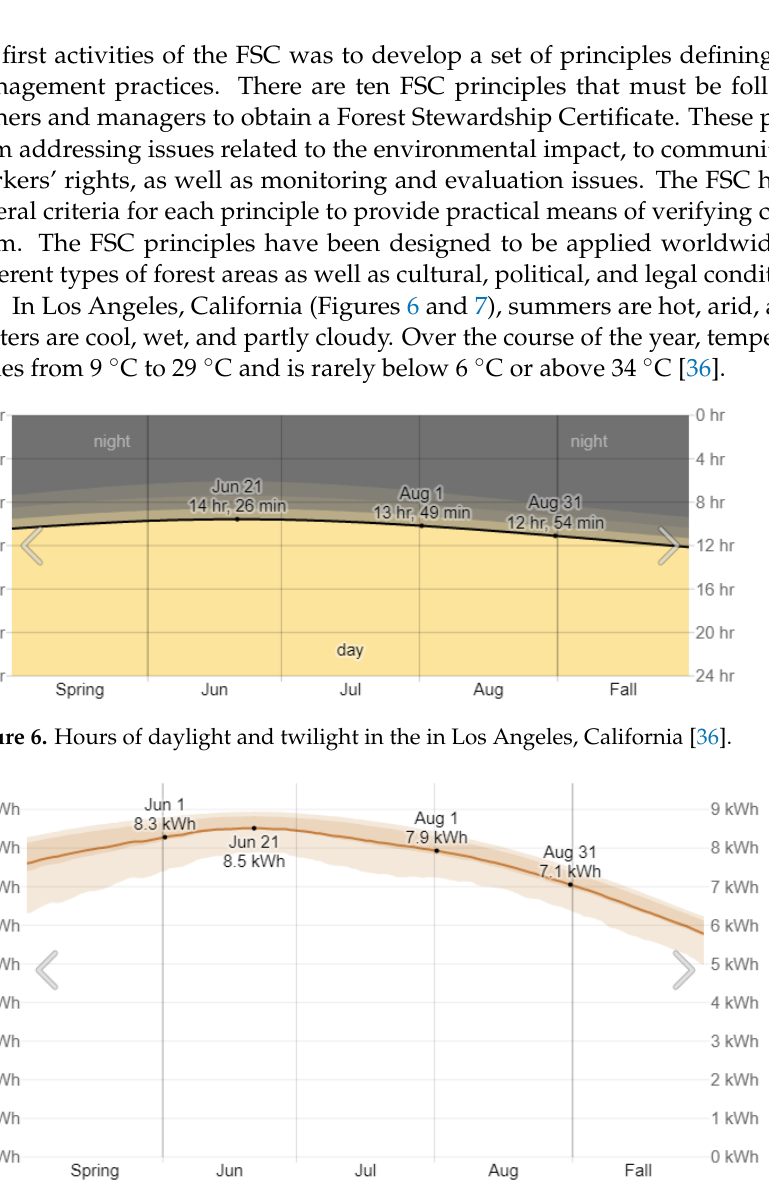
Figure 8. SEM image showing microstructure of ‘artificial stone’, i.e., brick/mortar, which was made of natural quartz sand SiO 2 (90% by weight), lime CaO (7% by weight), and water H 2 O (about 3% by weight); magnification 350×.